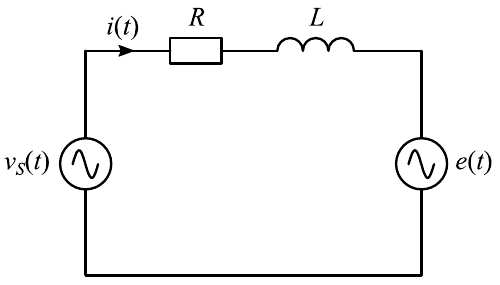
Figure 1. Equivalent circuit of a power converter application.